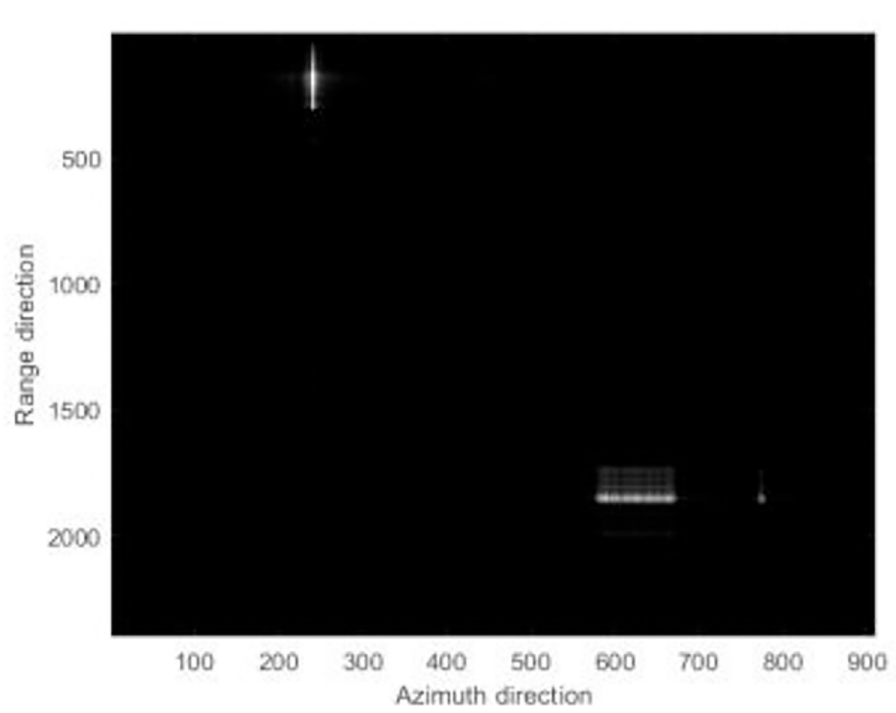
Fig 8. The simulation focused results.